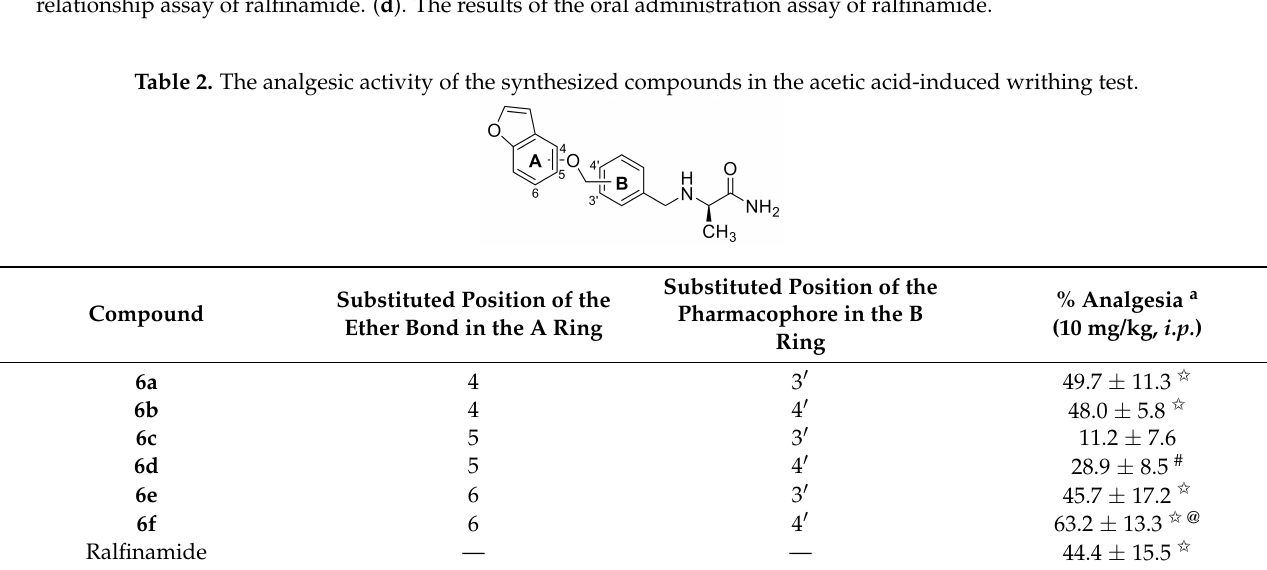
— a Data are presented as the mean ± standard deviation. Two-tailed Student’s t test. ☆ p < 0.001 compared to vehicle. # p < 0.05 compared to vehicle. @ p < 0.05 compared to ralfinamide.